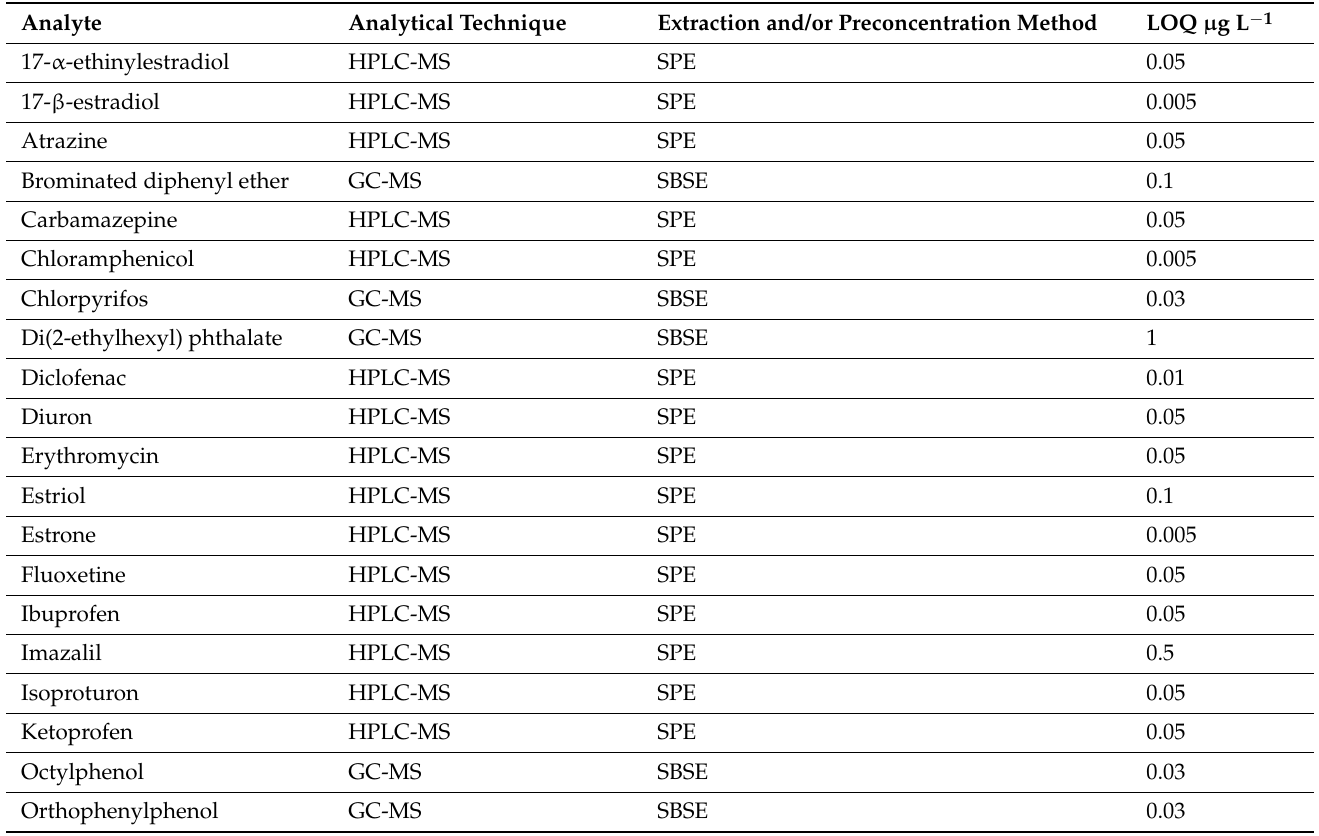
Table 2. Analytical technique used for each